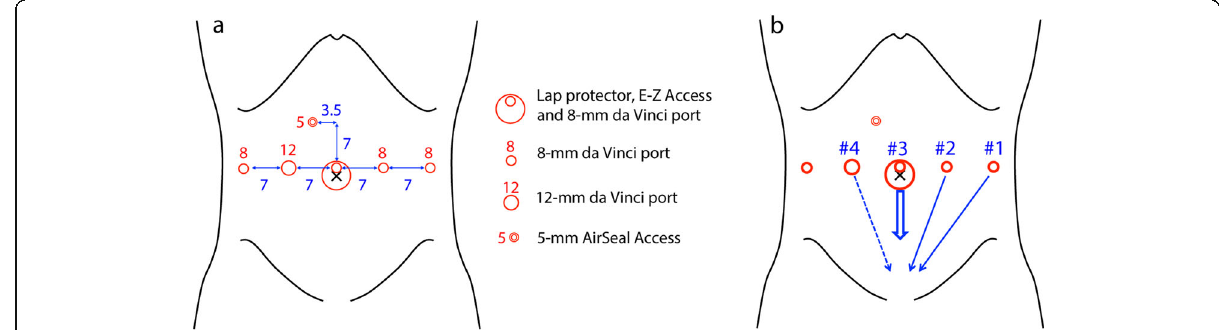
Fig. 2 Schematic representation of the port placement. a A 3-cm longitudinal incision was placed on the umbilicus, and Lap Protector and E-Z access were inserted there. The first camera port (8-mm da Vinci port) was placed through E-Z access, and pneumoperitonium was started. Additional four da Vinci ports were placed symmetrically along the horizontal line of the umbilical incision with 7-cm intervals. A 5-mm AirSeal Access port was inserted in the right upper quadrant. b #1, fenestrated forceps; #2, fenestrated forceps with bipolar; #3, 0° camera; #4, monopolar curved